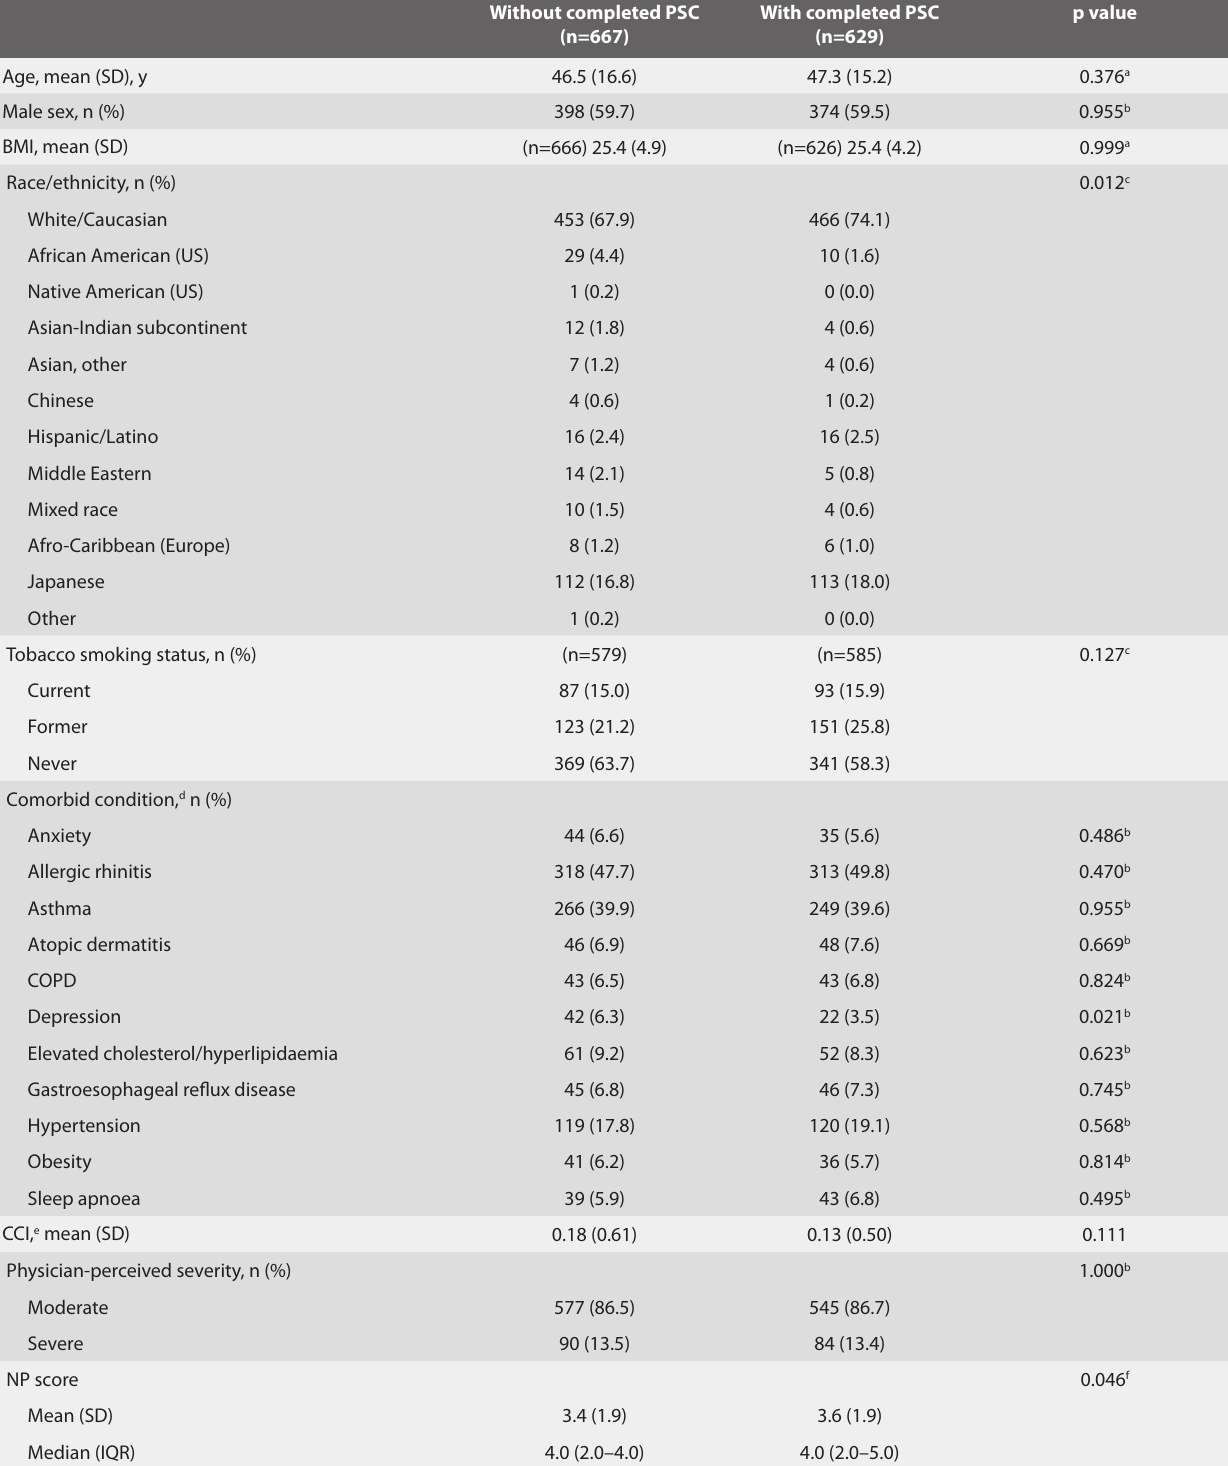
Supplemental Table 1. Sensitivity analysis of matched patient/physician